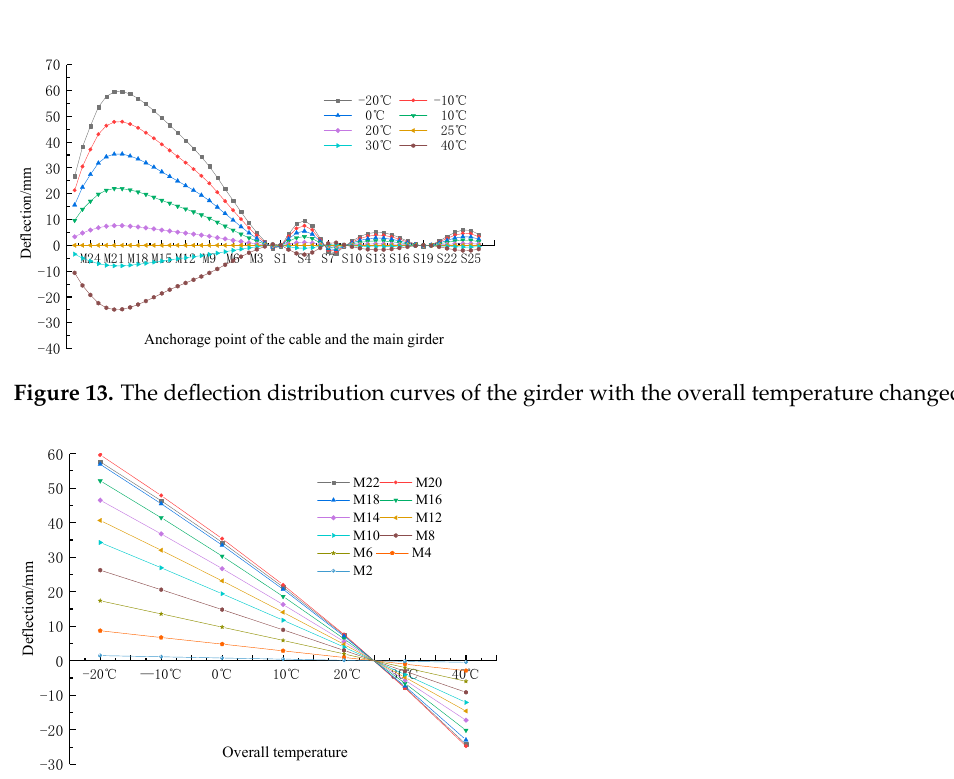
Figure 14. The deflection curves at different positions of the girder varying with the overall temper- ature.